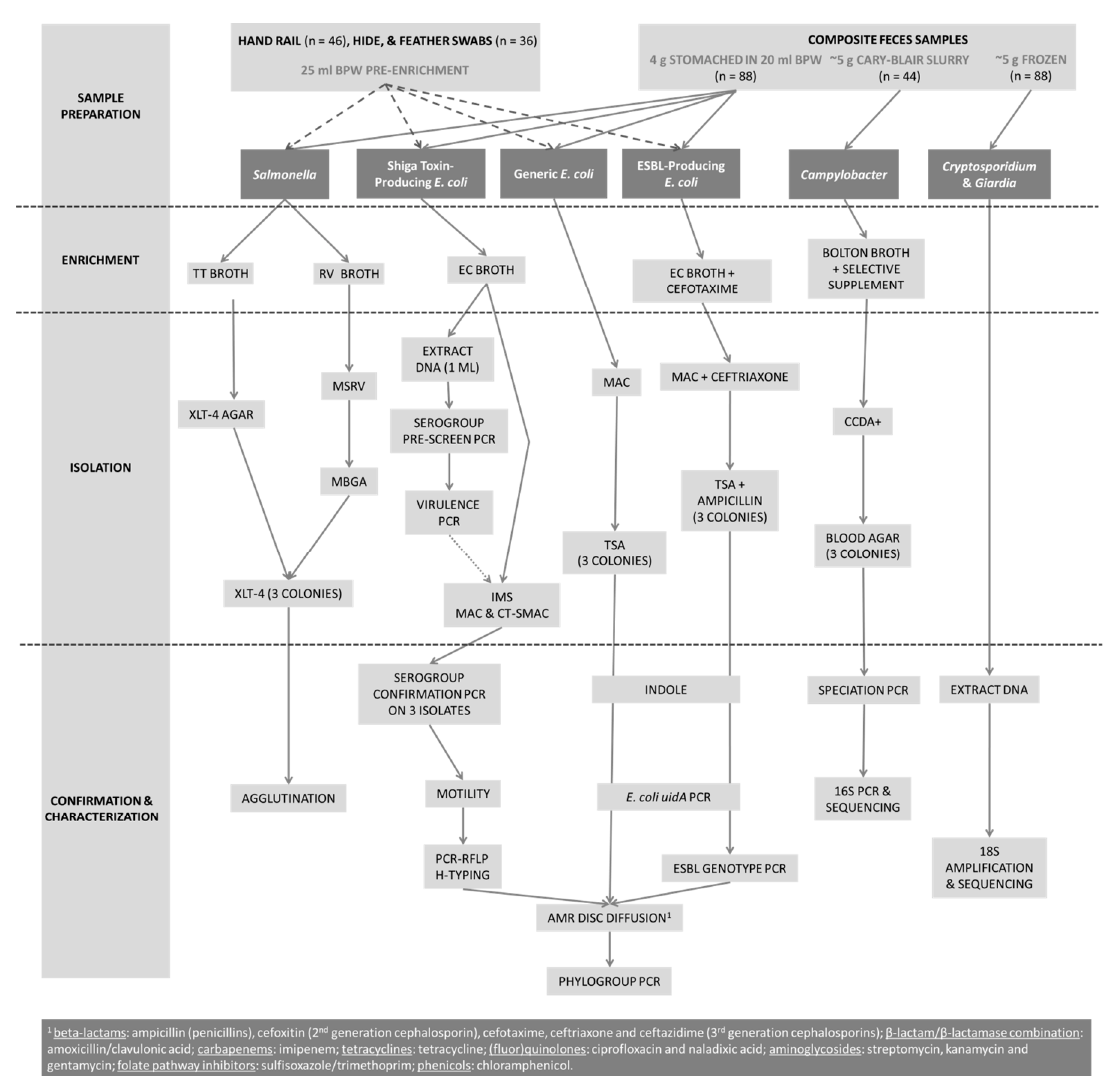
Figure 1. Flow chart representation of study methodology.